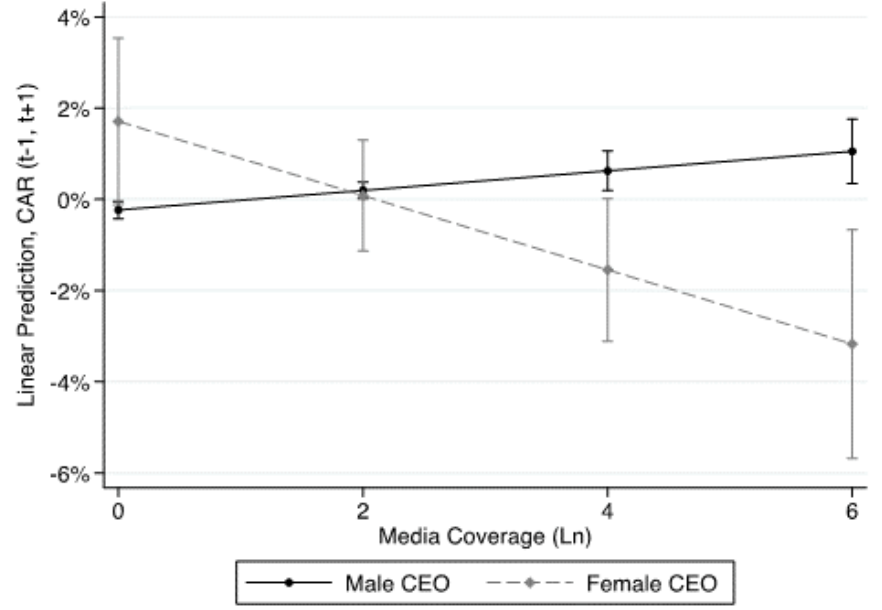
Figure 2: Marginal effects of media coverage on CAR, by CEO gender. Note: Ln, natural